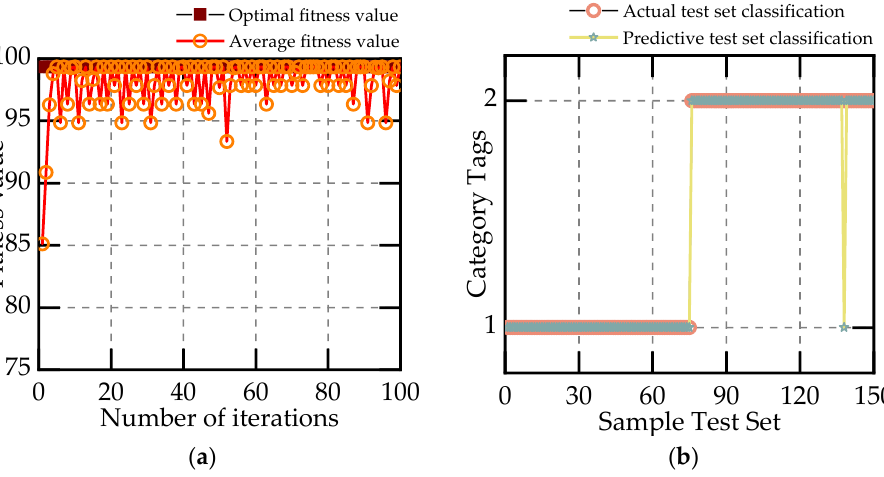
Figure 12. Classification graph of SSA-SVM classifier. ( a ) Adaptability curve. ( b ) Classification chart.